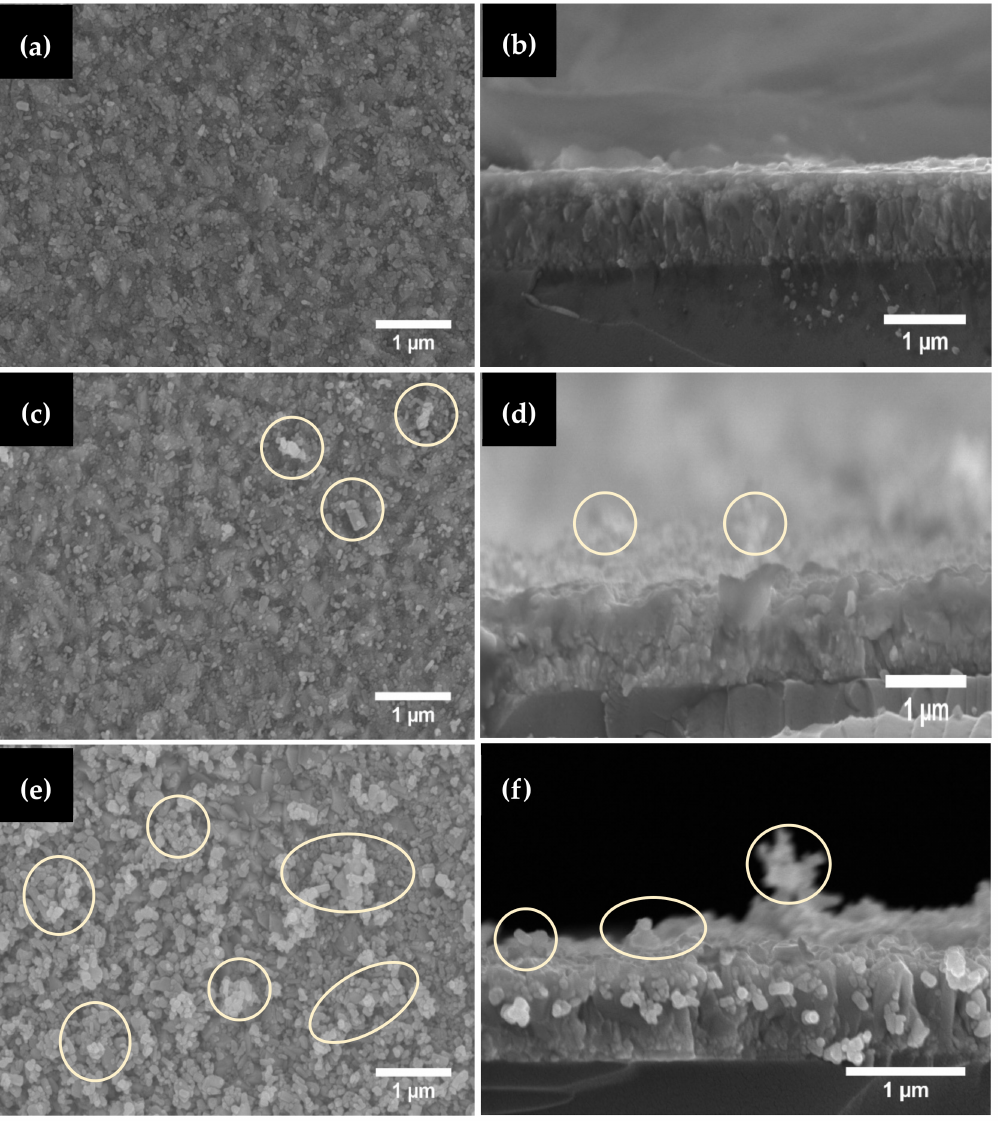
Figure 5. FESEM images showing the surface morphology of ( a ) AZ-I, ( c ) AZ-II, ( e ) AZ-III films, and cross-sectional view of ( b ) AZ-I, ( d ) AZ-II and ( f ) AZ-III films produced under different deposi- tion